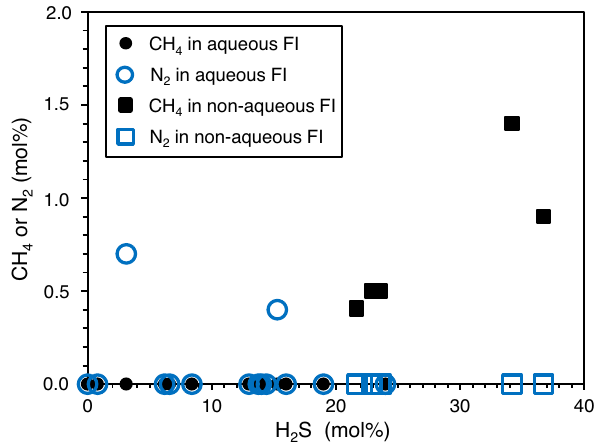
Fig. 3 Gas compositions of fl uid inclusions in black barites as measured by Raman analysis. 0 % H 2 S implies that the fl uid inclusion largely contains CO 2 . FI fl uid inclusions.